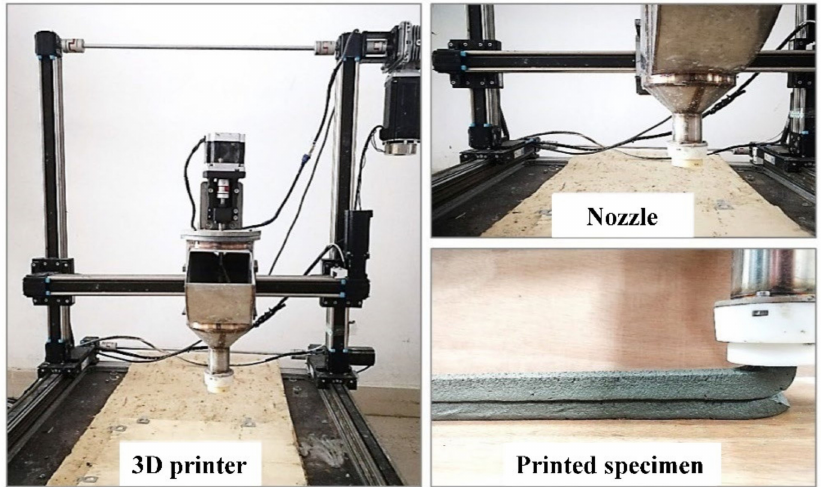
Figure 8. Medium sized gantry 3D